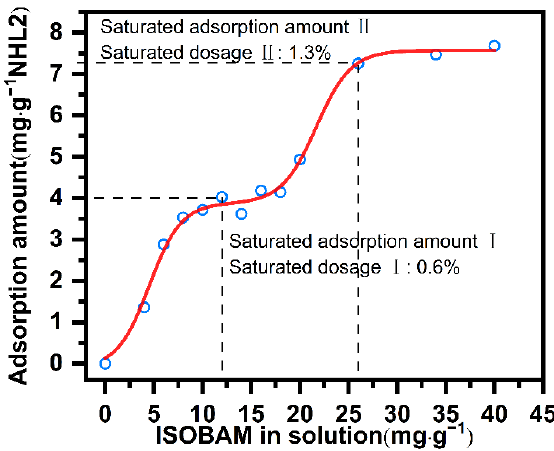
Figure 2. Isotherm of the adsorption of IBMA on the surface of NHL particles.